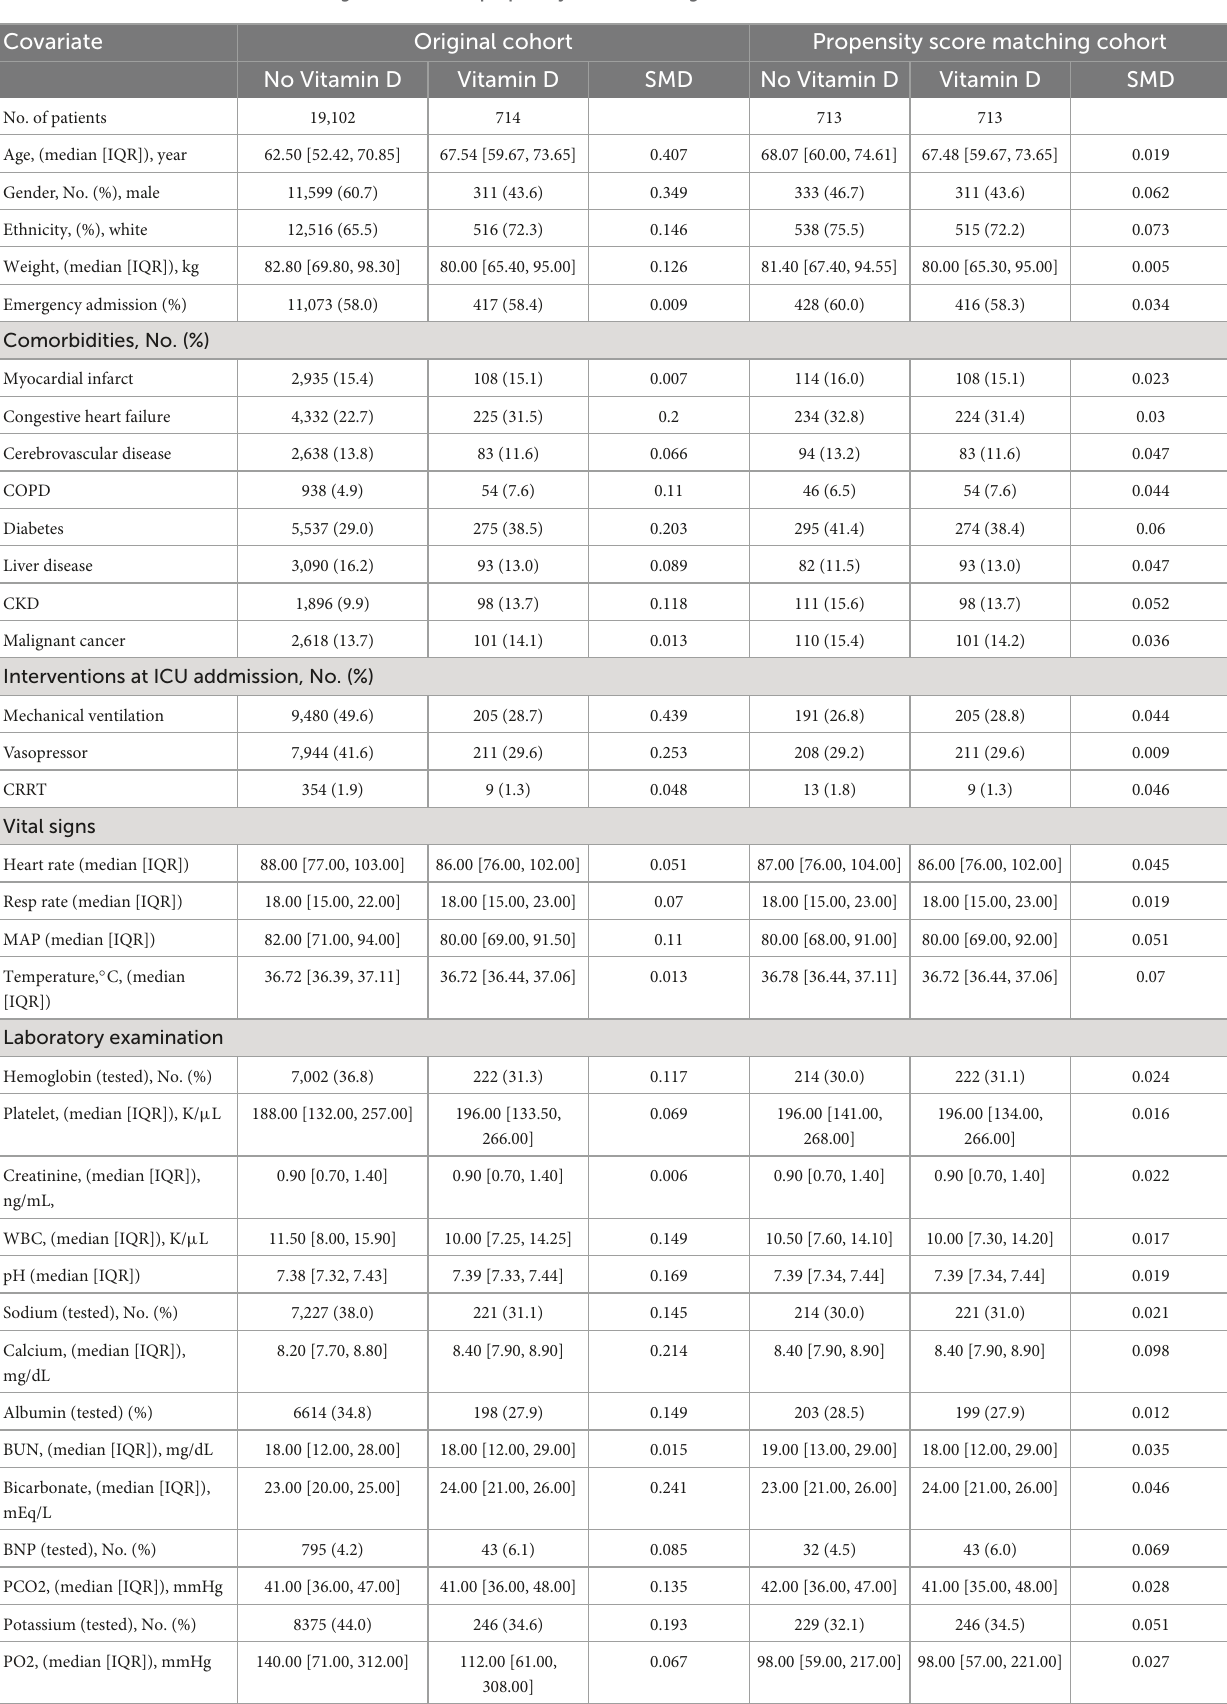
TABLE 1 The clinical characteristics of original cohort and propensity score matching cohort. Covariate Original cohort Propensity score matching cohort No Vitamin D Vitamin D SMD No Vitamin D Vitamin